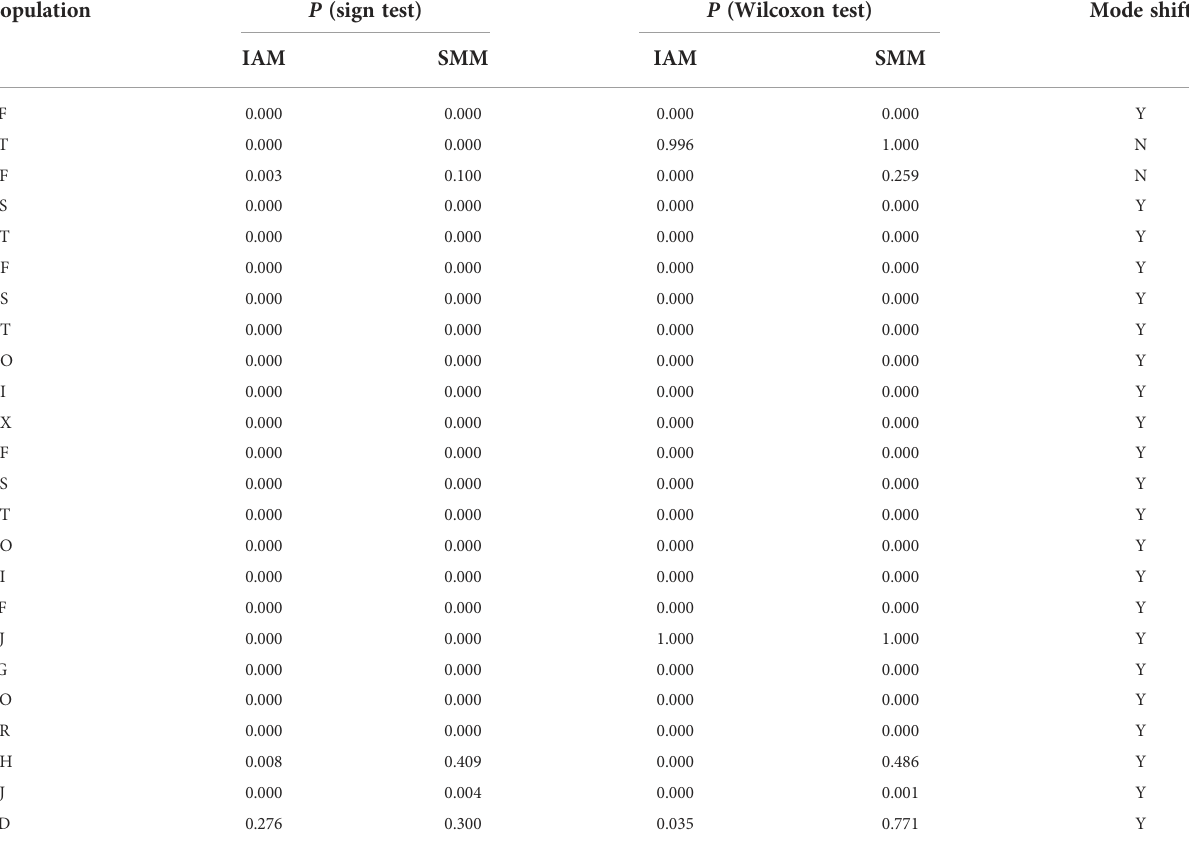
TABLE 3 Summary of Bottleneck results for 24 Sicyos angulatus populations in South Korea based on both Wilcoxon and sign tests under the in fi nite allele model (IAM) and stepwise mutation model (SMM).